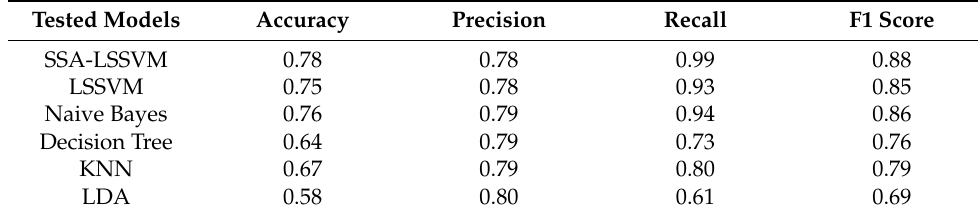
Table 9. Removal flow prediction model performance.